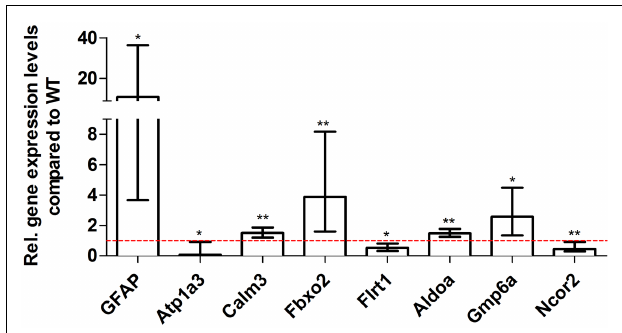
FIGURE 8 |Validation of aged 5XFAD deep sequencing results through quantitative real-time polymerase chain reaction (qRT-PCR) analysis .To confirm the deep sequencing data, qRT-PCR experiments for various genes were performed on aged 5XFAD and age-matchedWT mice. Expression levels of 5XFAD mice were compared to age-matchedWT animals (dashed red line representsWT standard). Normalization was performed against the